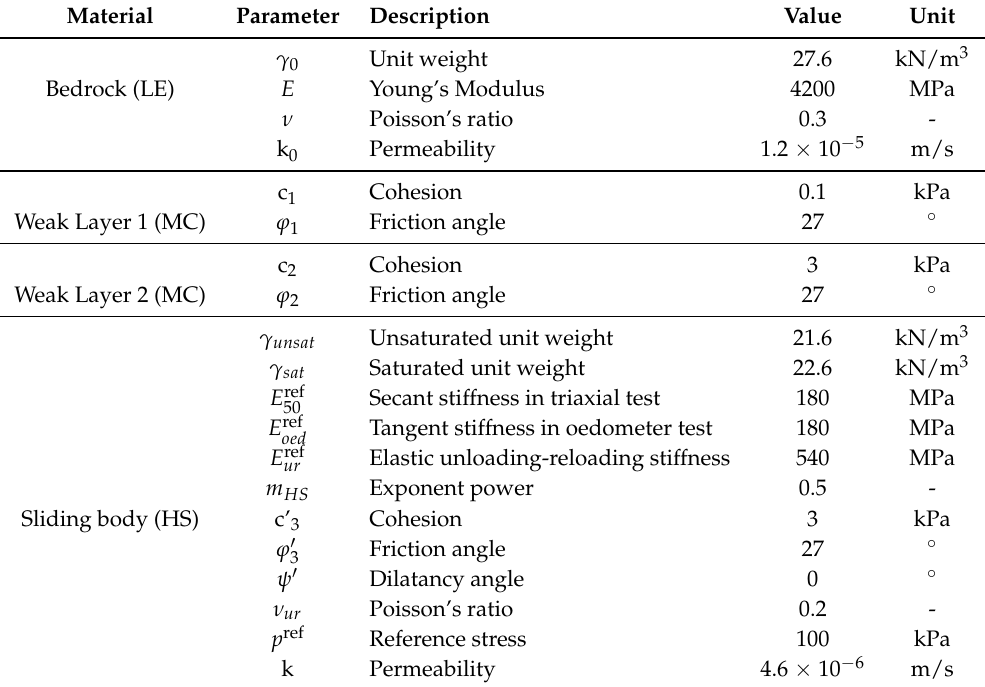
Table 1. Initial input parameters of the used constitutive model for different